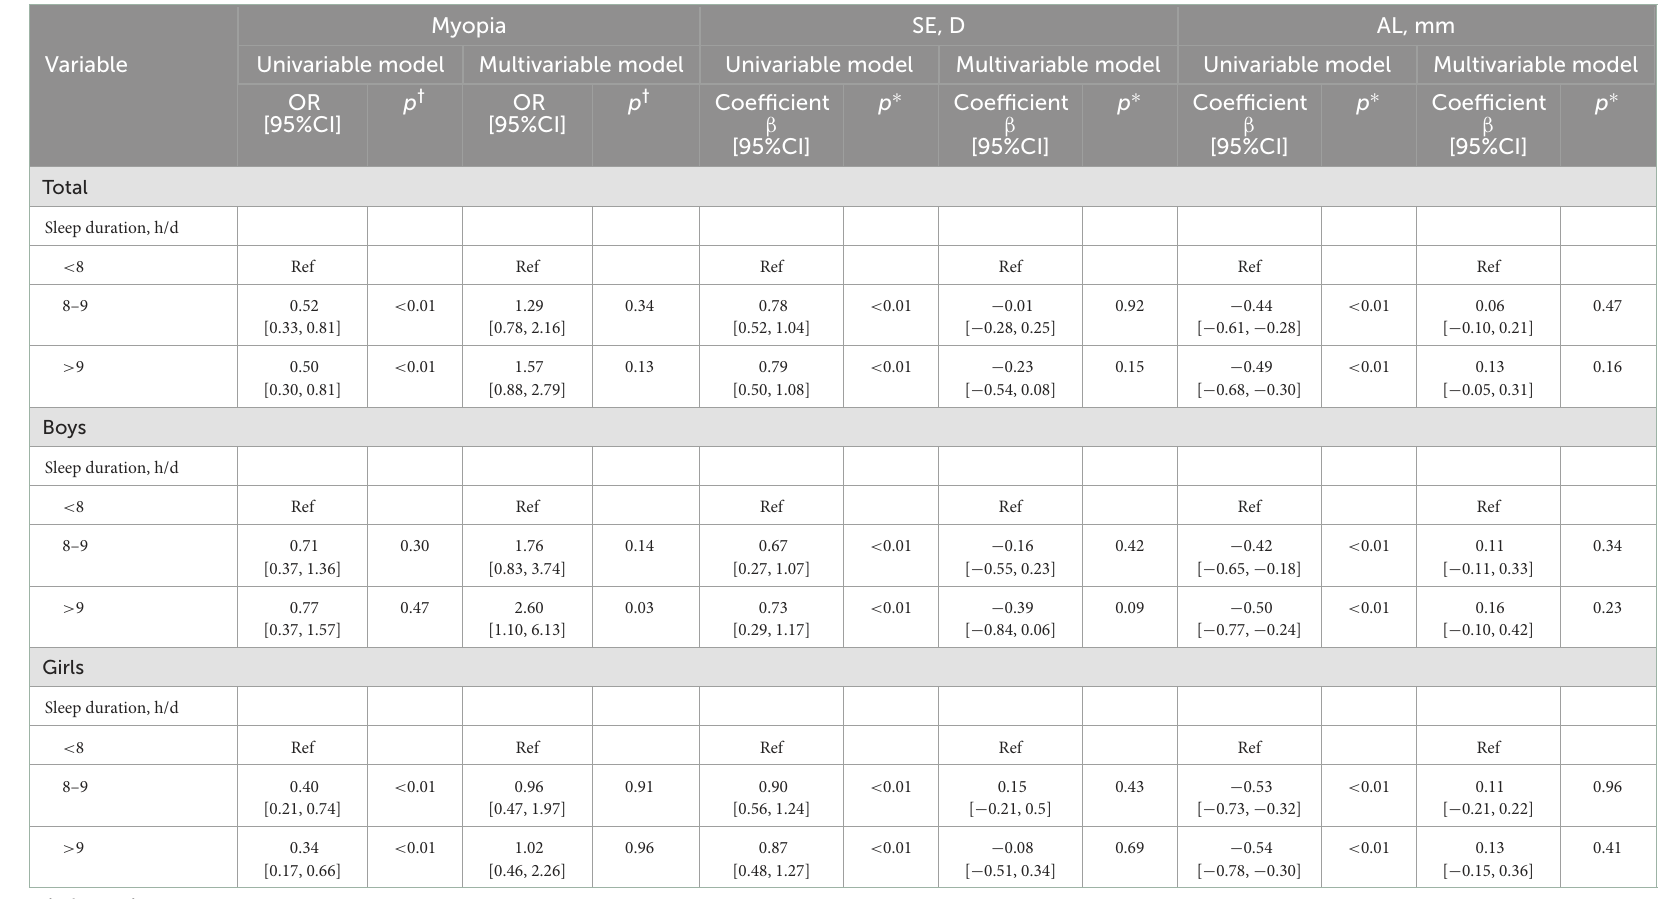
TABLE 3 Univariable and multivariable analysis of sleep duration in